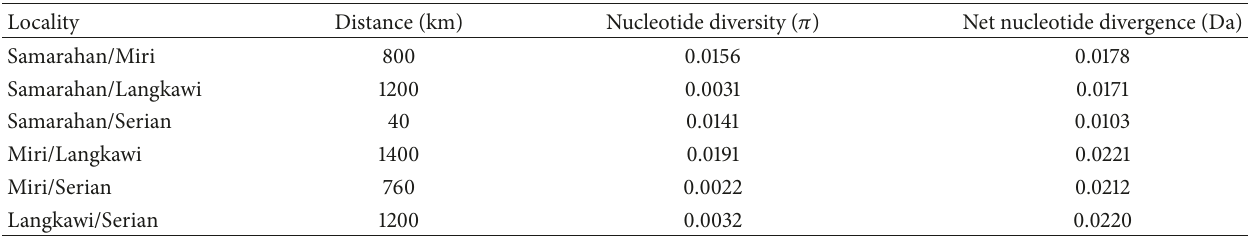
Table 5: Measures of nucleotide diversity ( 𝜋 ) and net nucleotide divergence (Da) among populations of T. schlegelii analyzed by location. Locality Distance (km) Nucleotide diversity ( 𝜋 ) Net nucleotide divergence (Da) Samarahan/Miri Samarahan/Serian Miri/Langkawi 1200 0.0032